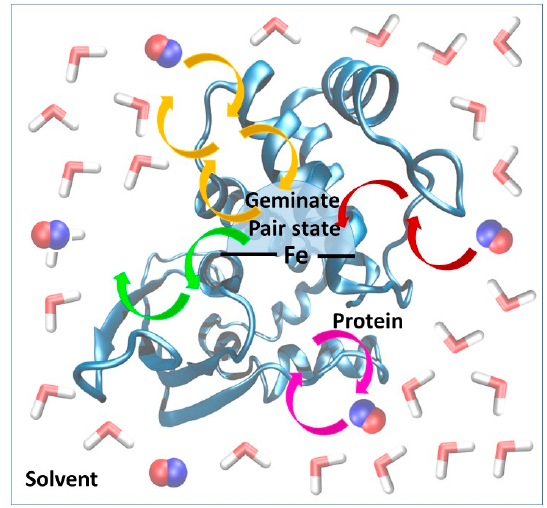
Figure 3. Schematic representation of the kinetic model used for the estimation of the rate constants for diffusion. The overall system has been divided into three parts: solvent phase (water molecules are shown in licorice), protein and geminate pair state (the geminate pair state is slightly smaller than the distal pocket). The heme group is represented by solid black lines. Ligand molecules (shown in van der Waals representation) may enter and leave the protein via various routes (indicated by yellow, green, pink and red arrows.). In the model, only those events are counted which represent the migration of the ligand from the solvent phase via the protein to the distal pocket and back to the solvent. Oscillations between the protein and the solvent / distal pocket are not taken into